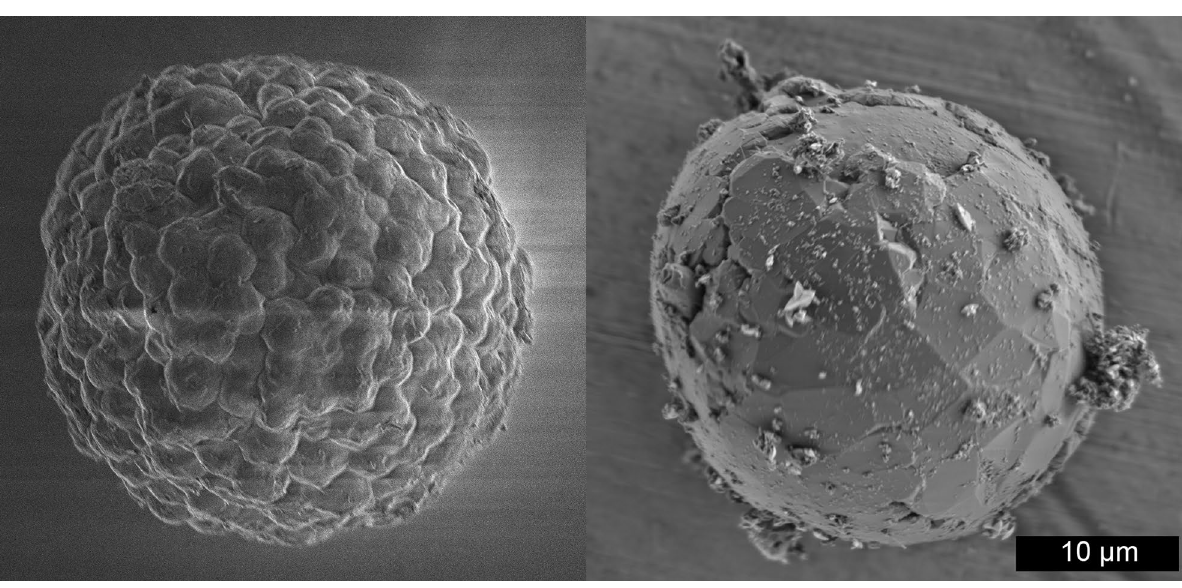
Figure 4. SEM images of raw spherical algae (left) and BCG made from spherical algae (right). Note that the BCG surface appears to be composed of the basal planes of interconnected graphite